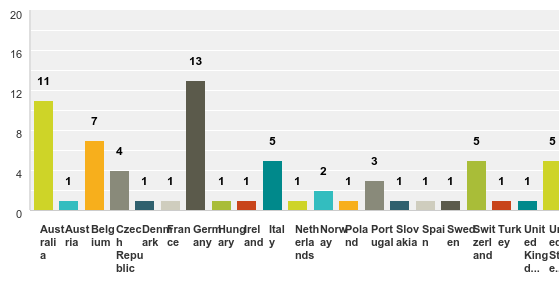
Figure 3 Distribution of participants that already use a UAV sensing system.